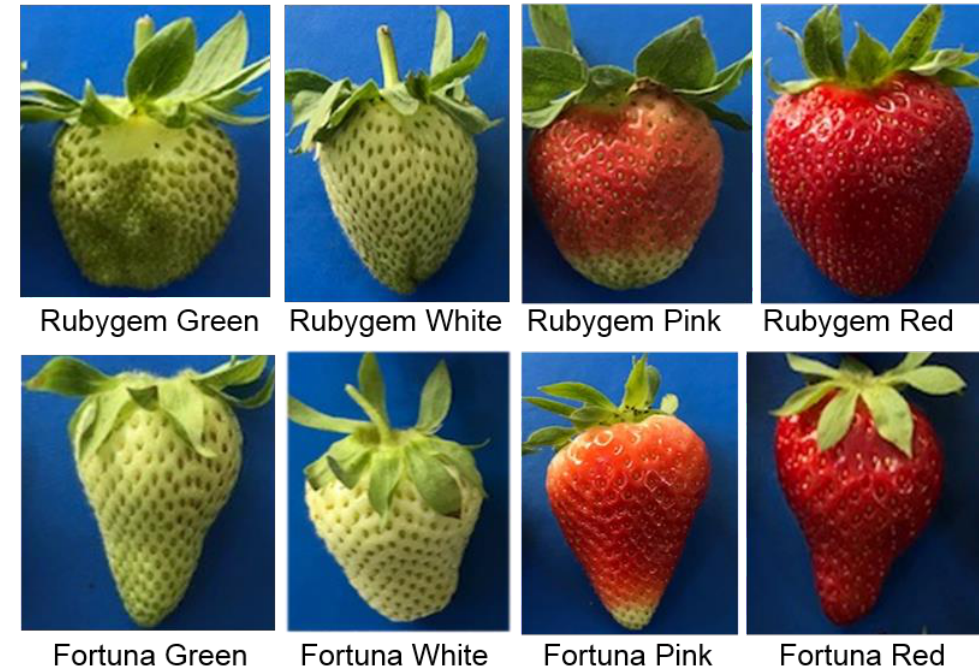
Figure 1. Different fruit developmental stages of two strawberry varieties.